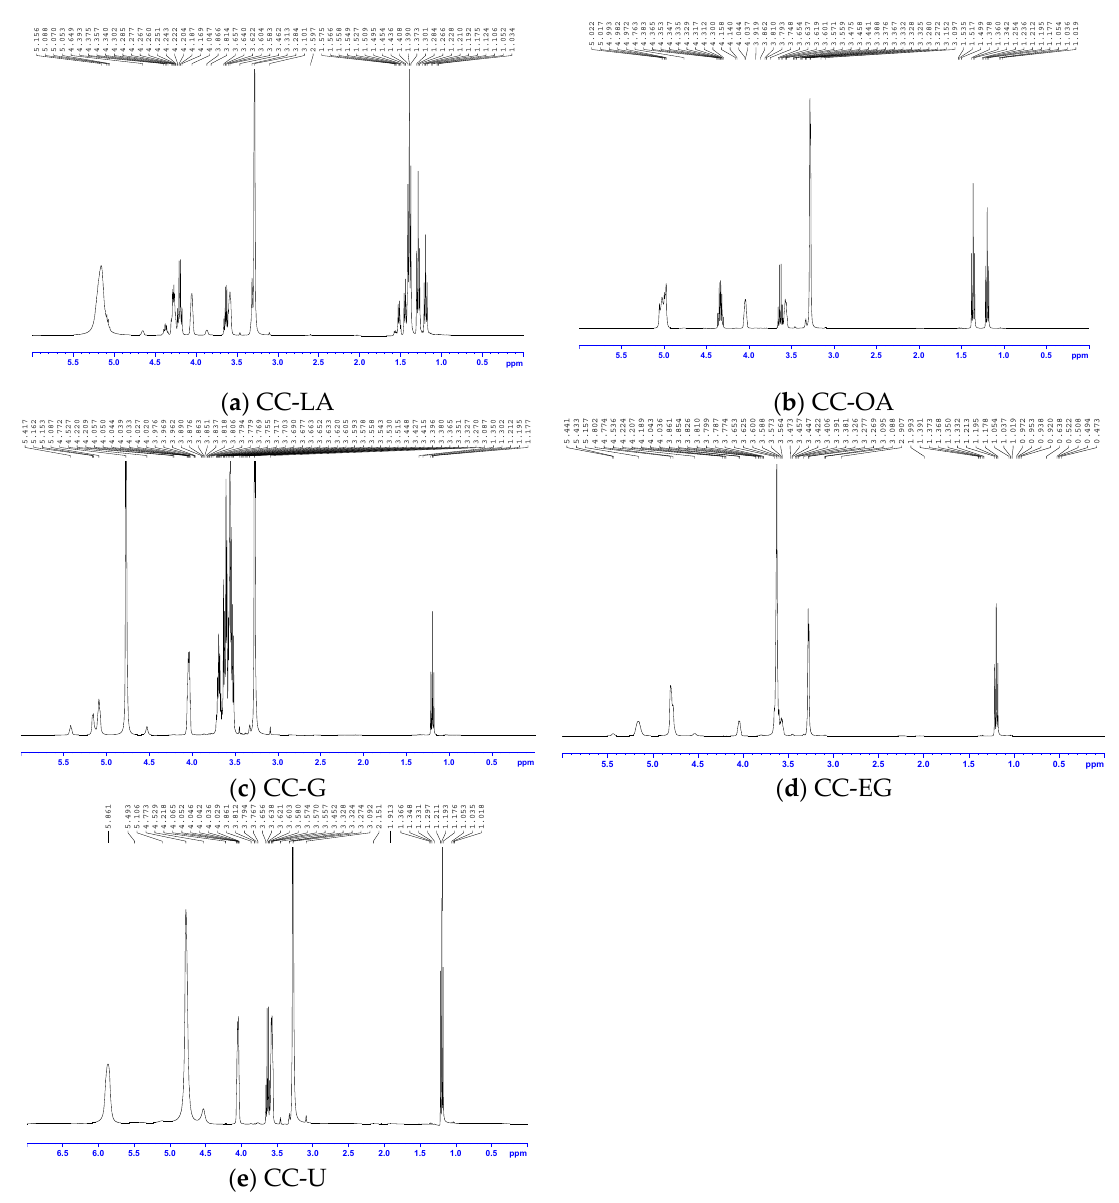
Figure 6. 1H-NMR spectra of lignin.